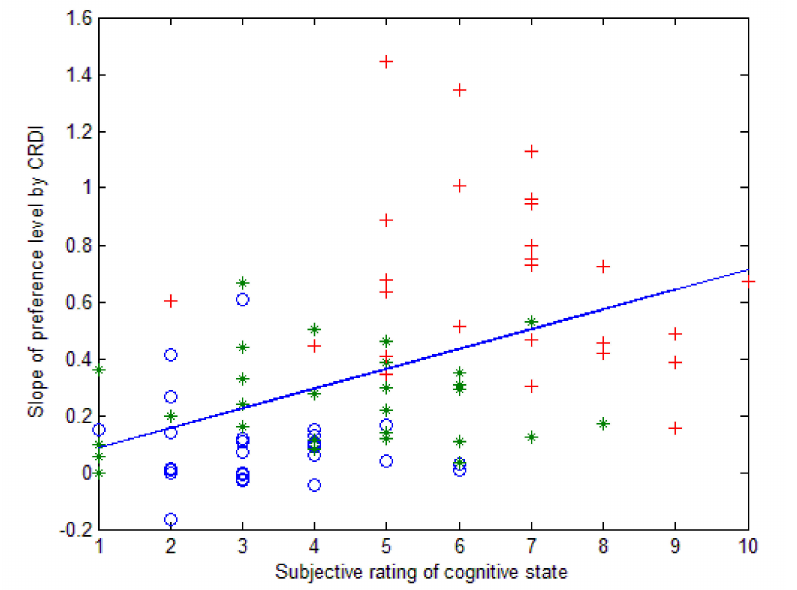
Figure 5. Median correlation between intensity and cognitive state, measured by Pearson’s product- moment correlation; correlation = 0.446, with p < 0.001; *: K.448; favourite